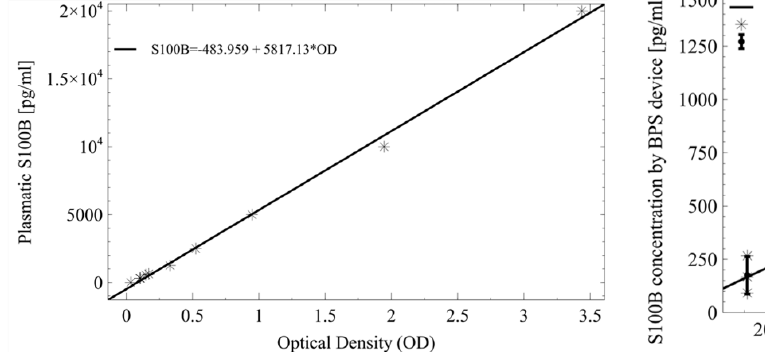
Table 3. Statistical comparison of conventional and paper-based blood plasma separation for measur-